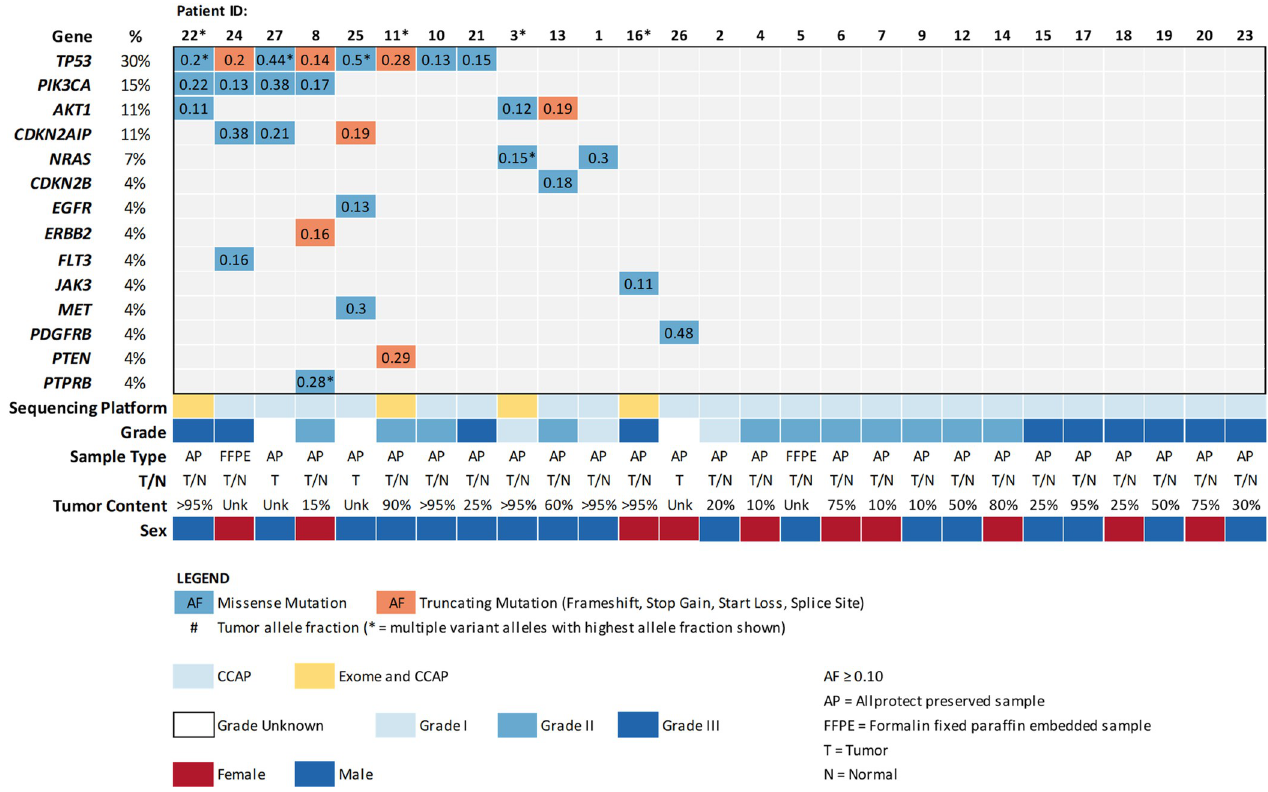
Fig 1. The landscape of somatic SNVs in splenic hemangiosarcoma. colored boxes, missense and truncating mutations identified by amplicon panel-based sequencing (CCAP) with allele frequencies � 0.1 are shown. Allele frequencies are indicated in colored boxes. Tumor content percentage and tumor grade are shown where available. Patient IDs with asterisks indicate samples that were also exome-sequenced.